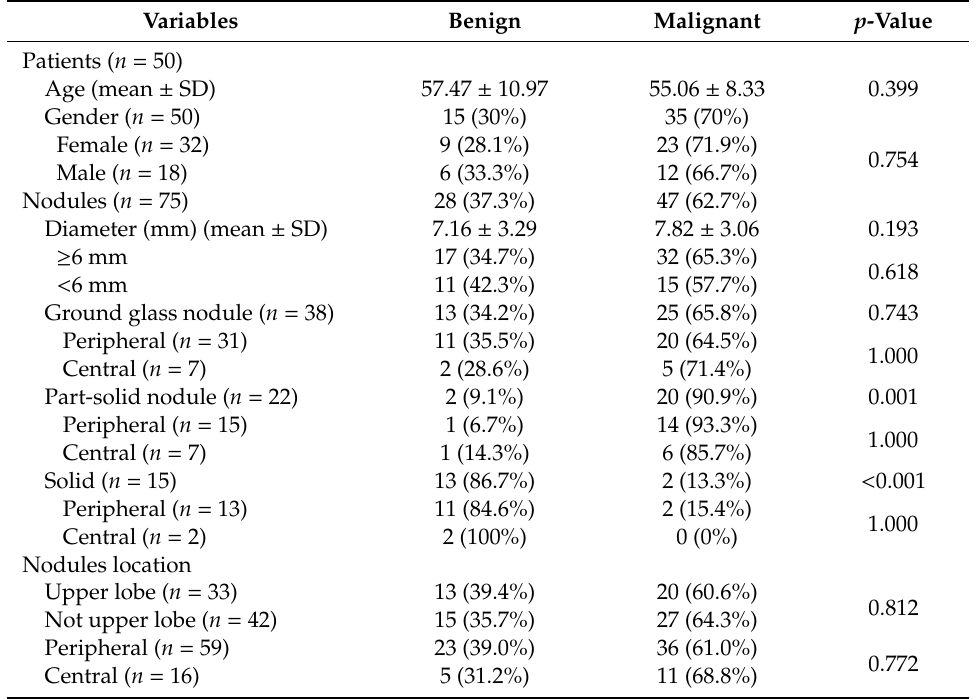
Table 1. The demographic data of 50 patients and imaging findings of 75 nodules shown on low-dose computed tomograms as well as their vessel-suppressed